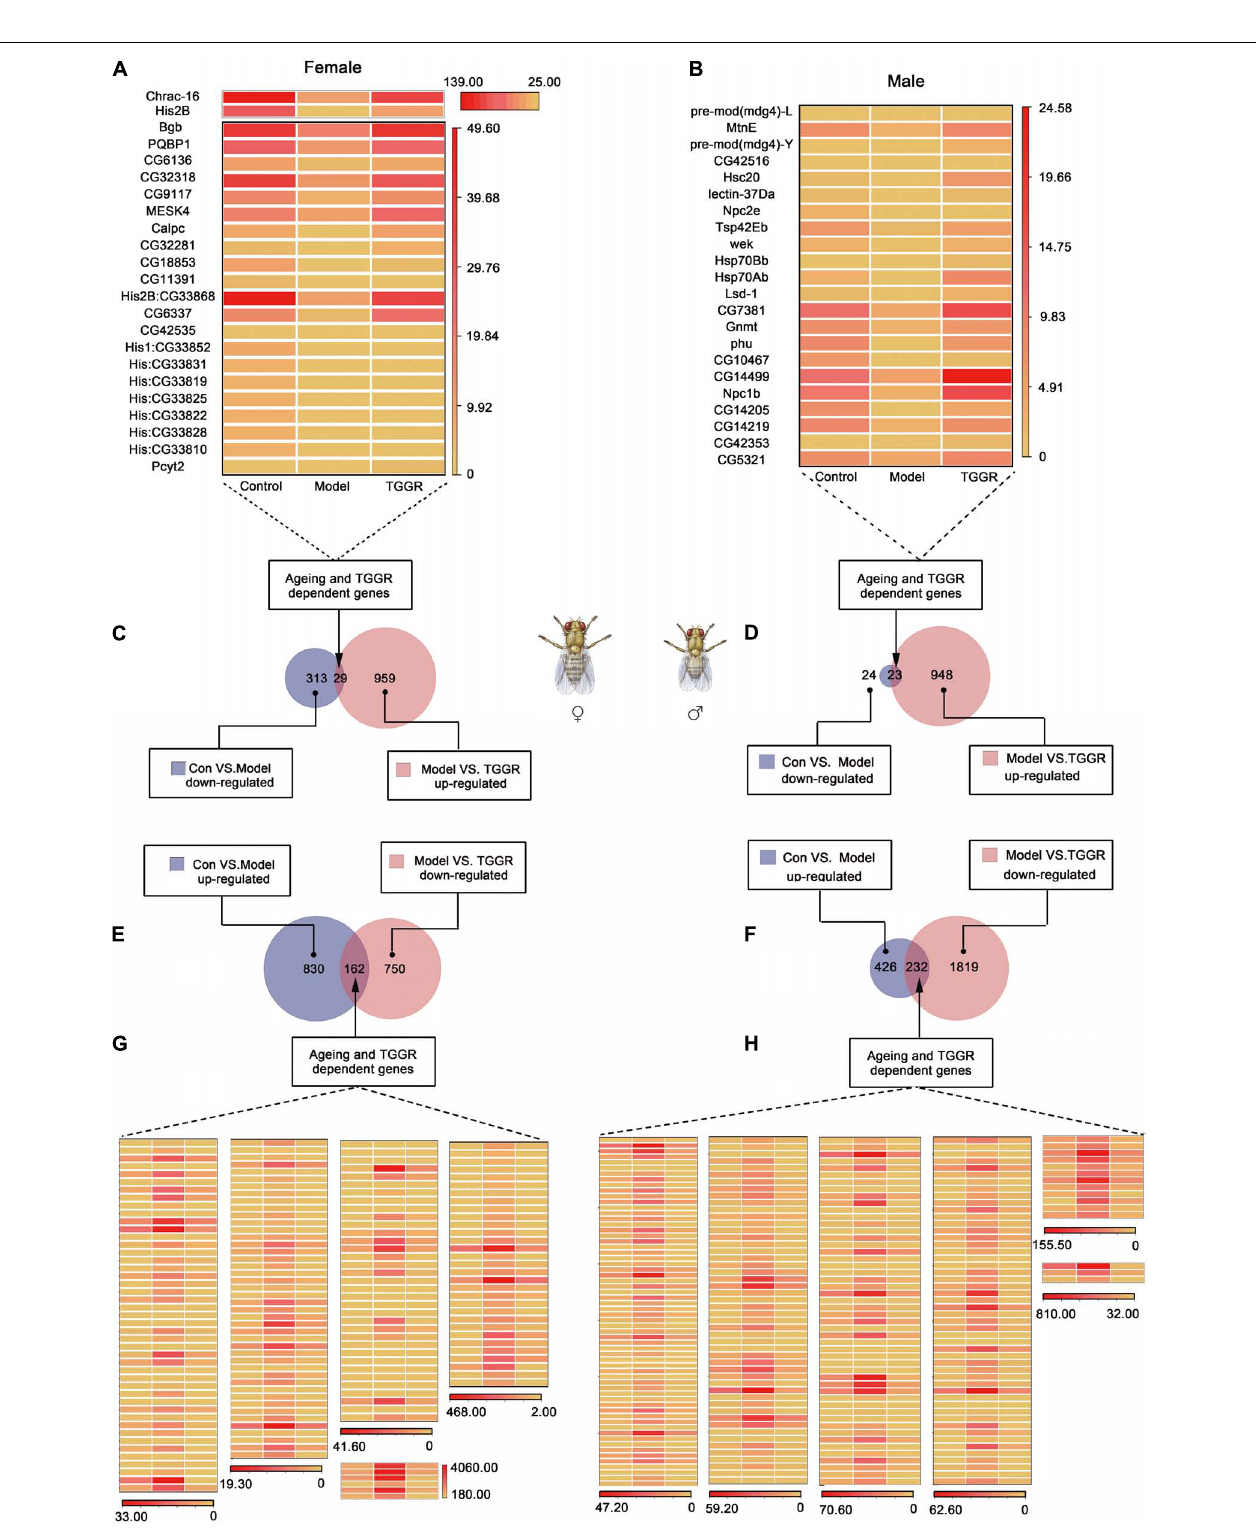
FIGURE 6 | Analysis of differential gene expression. (A,B) and (G,H) Genes with aging- or TGGR-induced fold changes in expression are represented by heatmaps. (C–F) Venn diagrams of aging and TGGR regulation of differentially expressed genes (female, A,C,E,G ; male, B,D,F,H ). “Control” was 7-day-old flies, “Model” was 40-day-old flies, and “TGGR” was 40-day-old flies with TGGR (5 mg/mL) treatment.